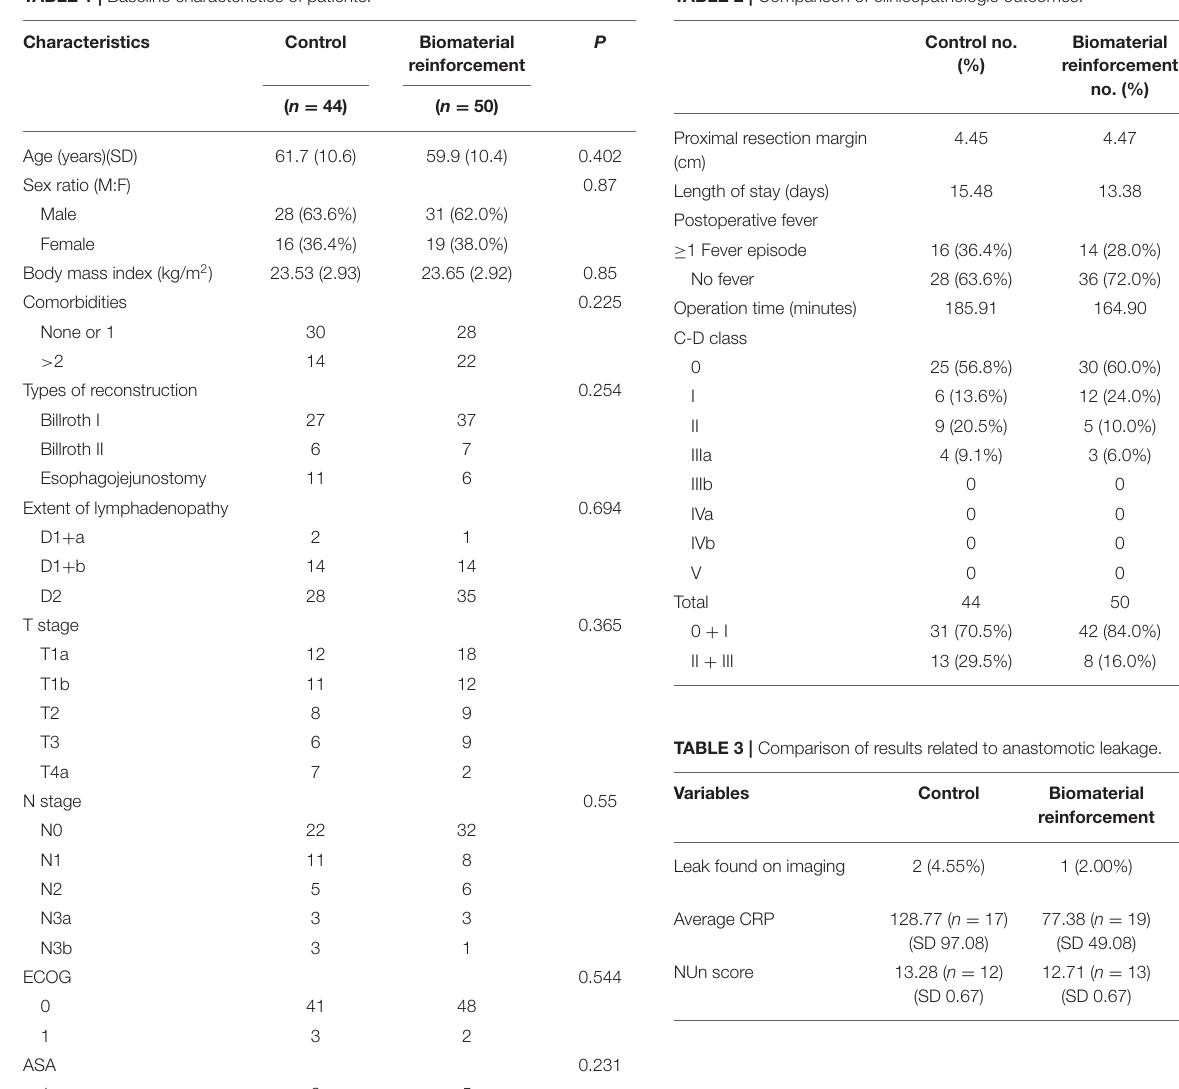
TABLE 1 | Baseline characteristics of patients. TABLE 2 | Comparison of clinicopathologic outcomes.